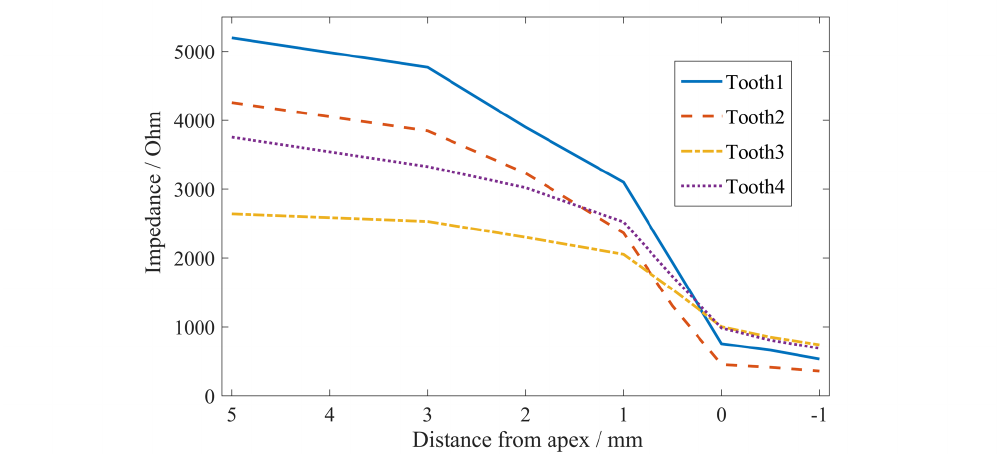
Figure 8. The impedance of different teeth varying with the distance between the file and the apical foramen.